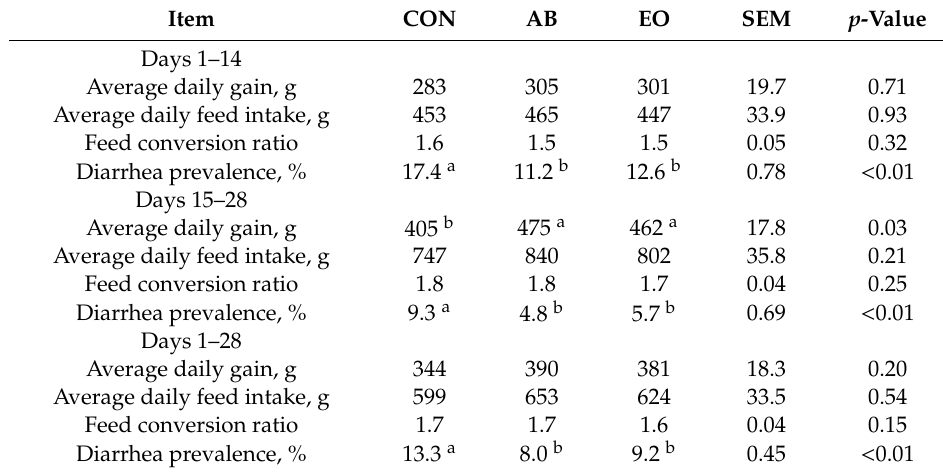
Table 3. E ff ects of essential oil supplementation on the growth performance and diarrhea prevalence of weaned piglets 1